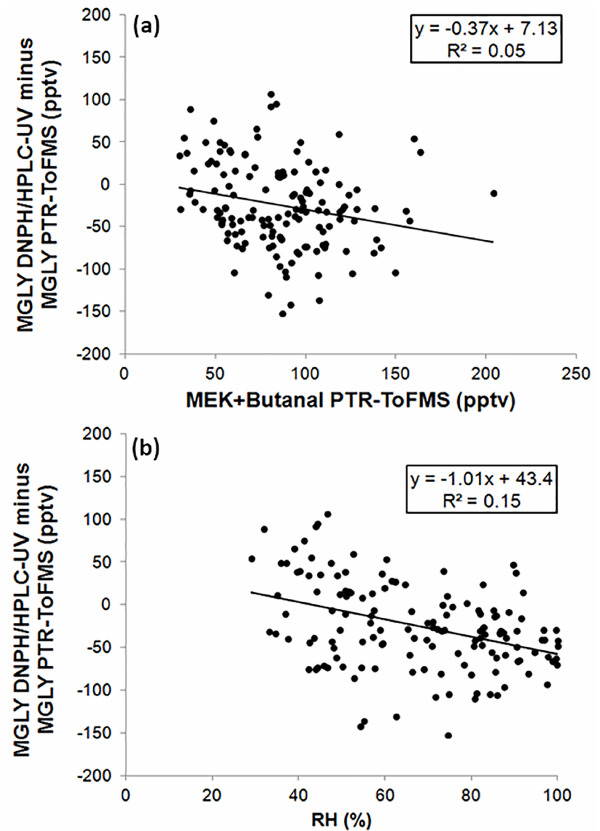
Figure 5. Scatter plots of the difference between the two techniques and MEK + butanal (a) or relative humidity (RH, b